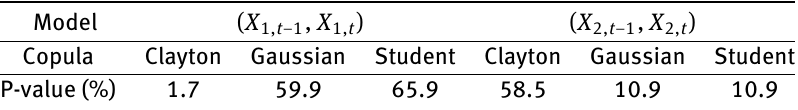
Table 5: P-values of goodness-of-fit tests for ( X 1, t −1 , X 1, t ) and ( X 2, t −1 , X 2, t ) , computed with 1000 bootstrap samples.